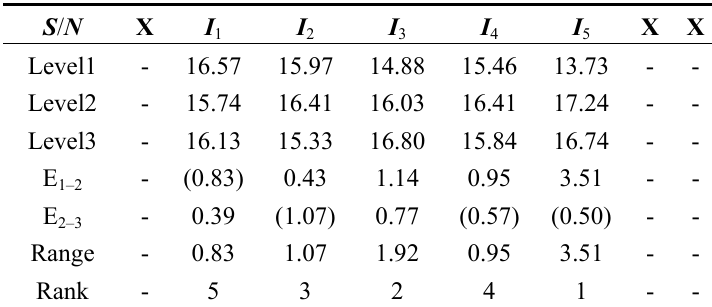
Table 10. Response table for the S / N ratio.